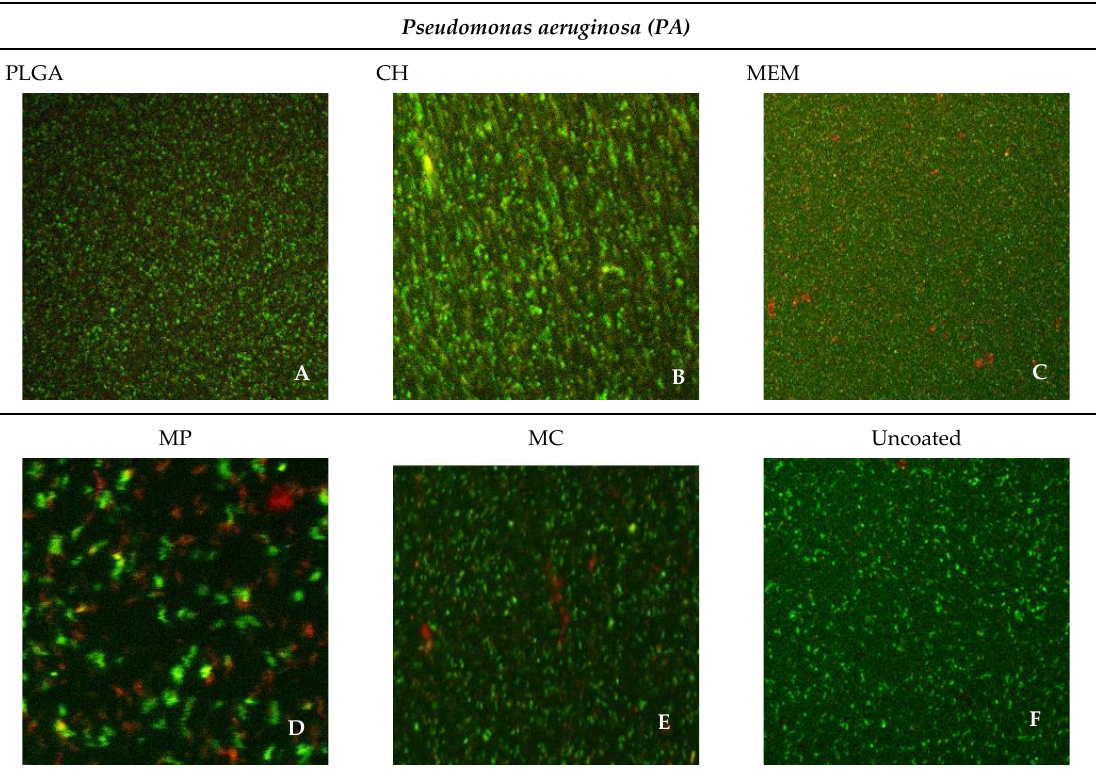
Pseudomonas aeruginosa (PA)